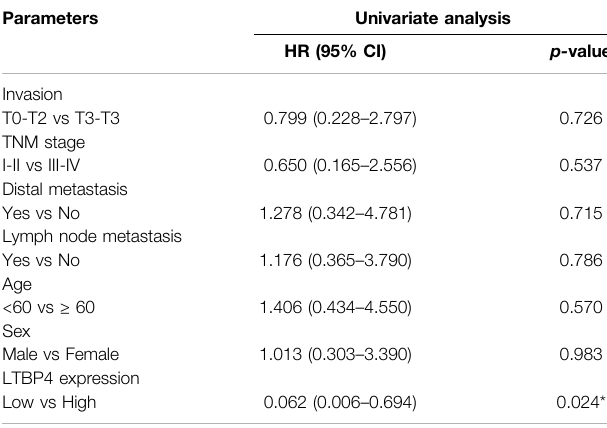
TABLE2| UnivariateCoxproportionalhazardsanalysesofLTBP4expressionand overall survival for patients with